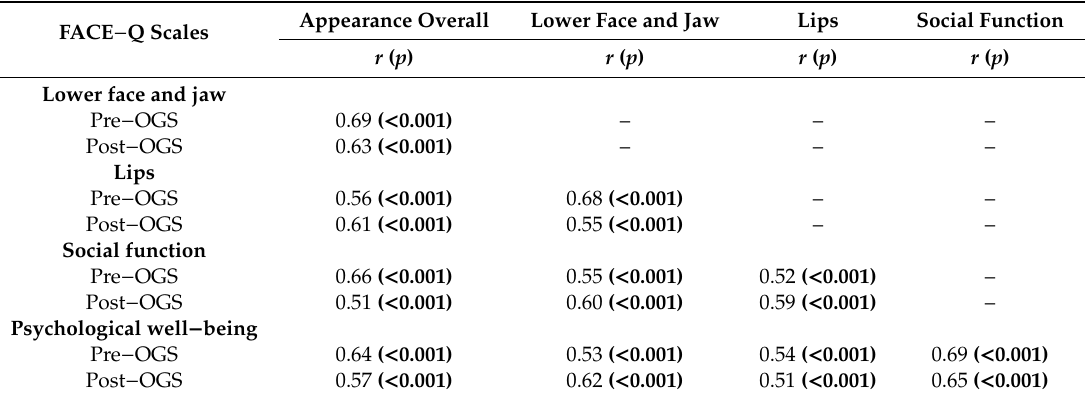
Table 5. Correlations for Pre − and Post − Orthognathic Surgery Assessment of FACE − Q Scales. FACE − Q Scales